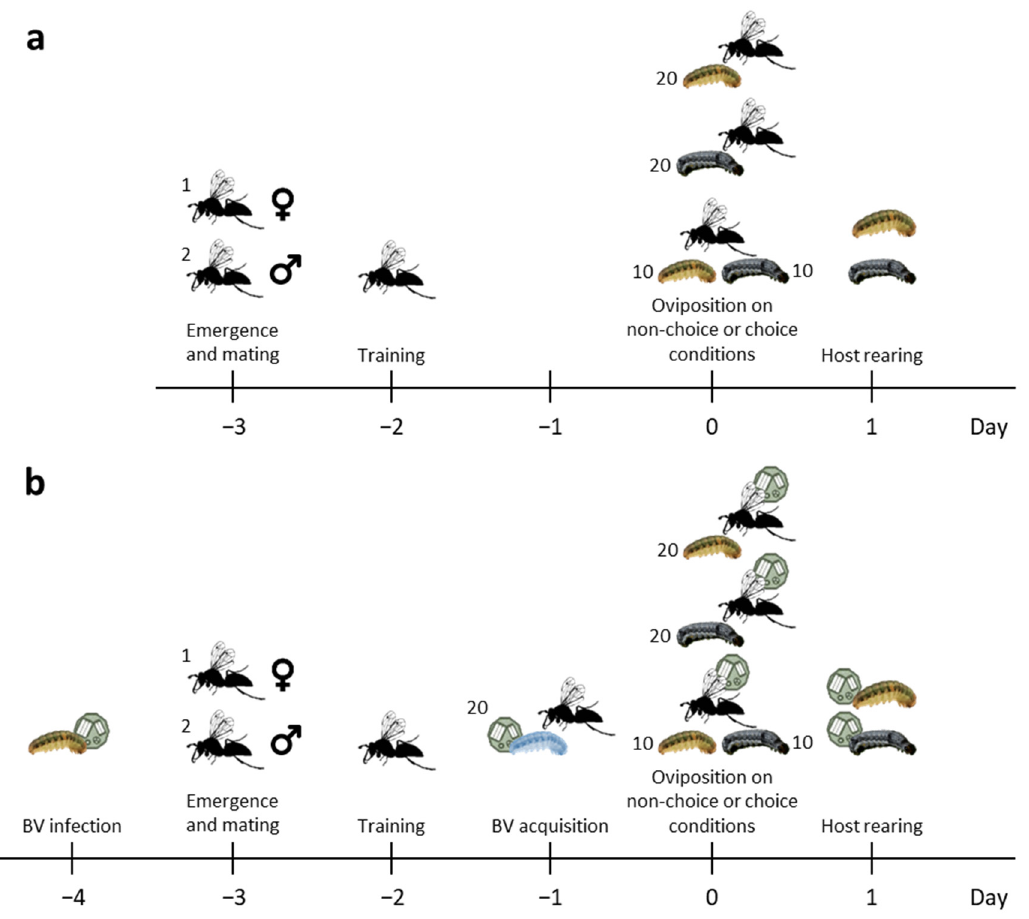
Figure 1. Timeline of the experiments. ( a ) Preference of Hyposoter didymator for Spodoptera exigua and Spodoptera littoralis; ( b ) transmission of AcMNPV by Hyposoter didymator to Spodoptera exigua and Spodoptera littoralis.